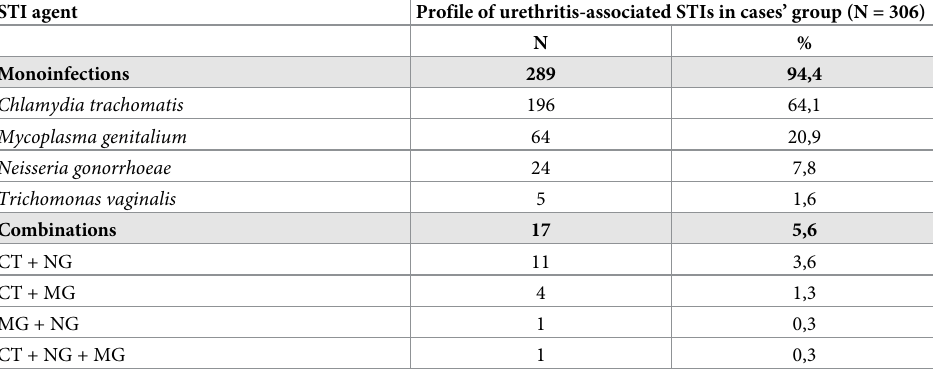
Table 1. Profile of urethritis-associated sexually transmitted infections (STI) defined by a polymerase chain reac- tion (PCR) method among the male patients consulting an andrologist after high-risk sexual behavior or for pro- phylactic control or fertility check. STI agent Profile of urethritis-associated STIs in cases’ group (N = 306)